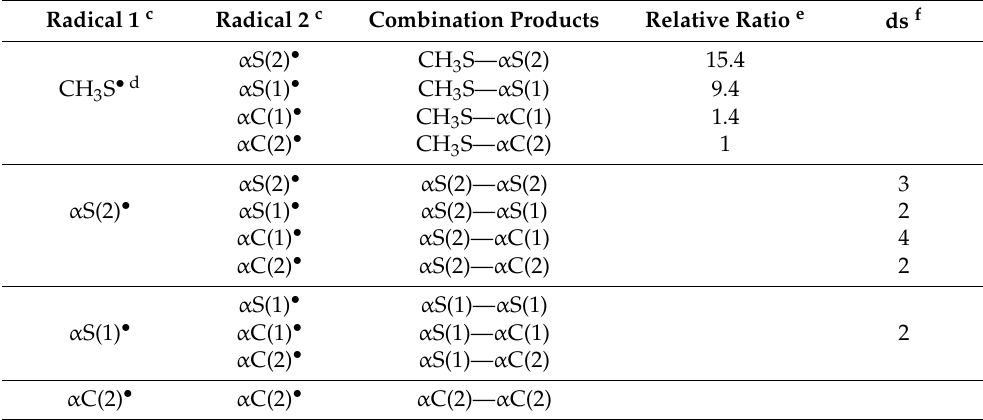
Table 3. Product formations by combination of various radicals in the experiment with starting material 1 a,b .